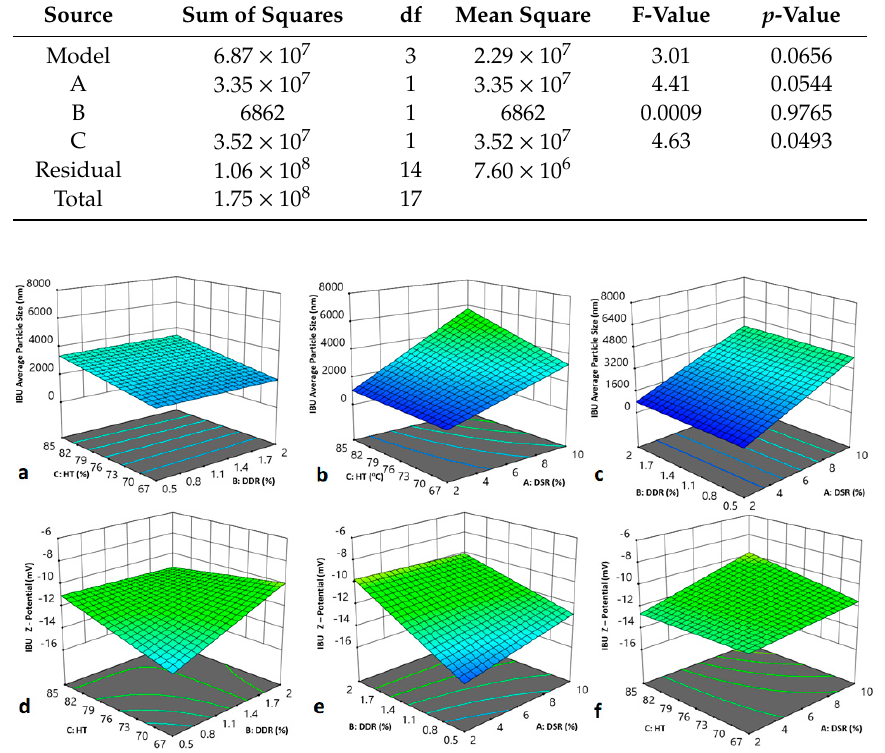
Figure 4. Response surface and contour plots of the main e ff ects on the particle size vs: ( a ) inlet temperature and drug-mannitol ratio, ( b ) inlet temperature and drug-stabilizer ratio, ( c ) drug-diluent and drug-stabilizer ratio, and ζ -potential vs: ( d ) inlet temperature and drug-mannitol ratio, ( e ) drug-mannitol and drug-stabilizer ratio, and ( f ) inlet temperature and drug-stabilizer